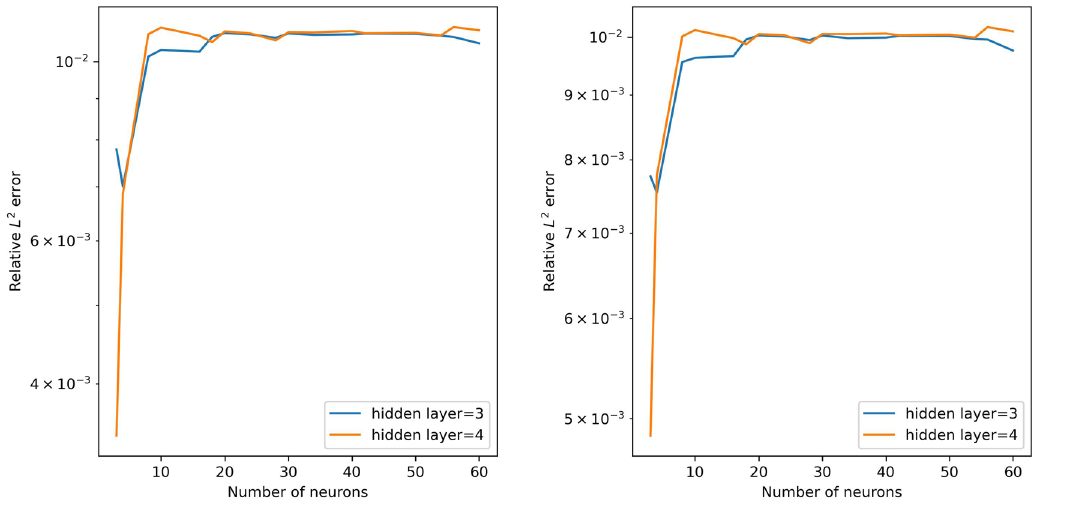
Figure 7. Number of neurons versus error (when number of hidden layers equals 3 and